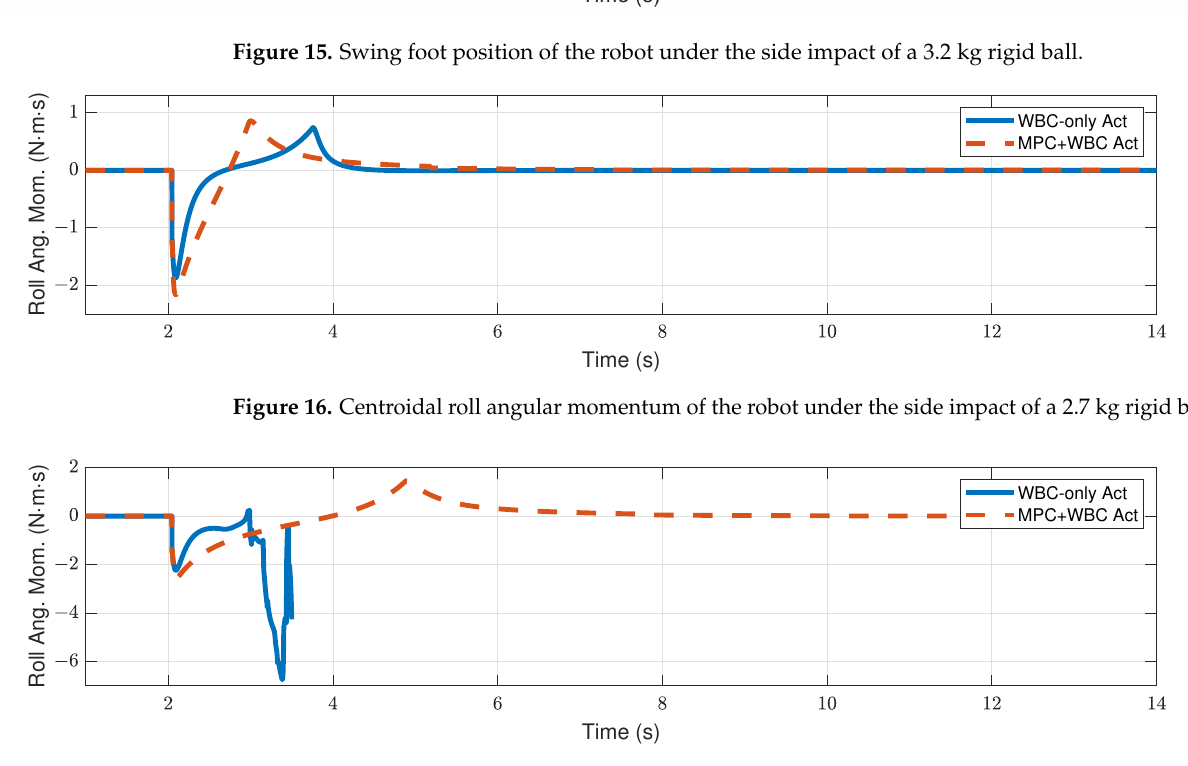
Figure 17. Centroidal roll angular momentum of the robot under the side impact of a 3.2 kg rigid ball.